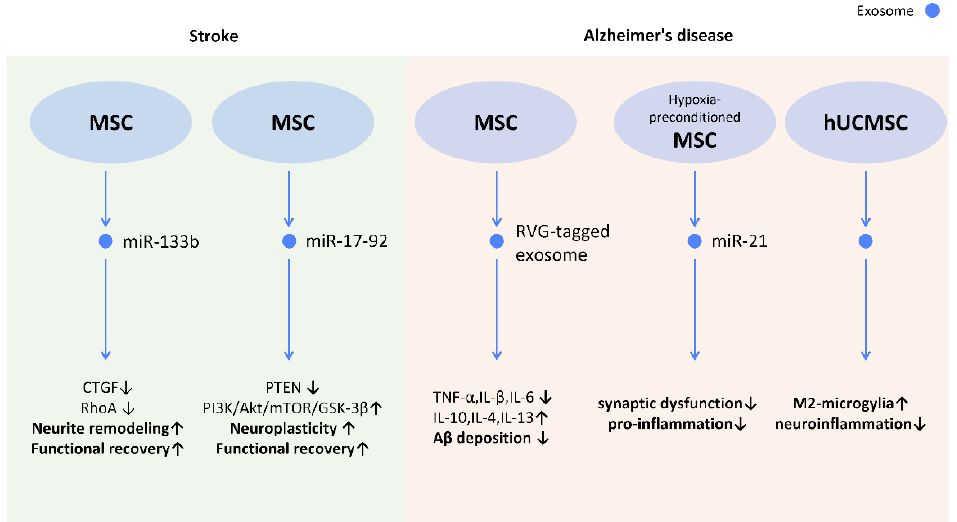
Figure 11. Molecular mechanisms of stem cell-derived exosomes in neurological diseases. Through shuttling molecules to neurons and glial cells, stem cell-derived exosomes possess the potential for neuronal regeneration, neuroprotection, and neuroinflammatory modulation. In stroke models, stem cell-derived exosomes promote neurite remodeling and neuroplasticity, contributing to enhanced functional recovery. In Alzheimer’s disease, stem cell-derived exosomes are shown to attenuate neuroinflammation and reduce Aβ deposition which manifested as improved memory and learning capacity. Abbreviation: CTGF: connective tissue growth factor; RhoA: ras homolog gene family member A; PTEN: phosphatase and tensin homolog; Akt: protein kinase B; mTOR; mechanistic target of rapamycin; GSK-3beta: glycogen synthase kinase 3β; hUCMSC: human umbilical cord mesenchymal stem cells. ↑ represents upregulation; ↓ represents downregulation.